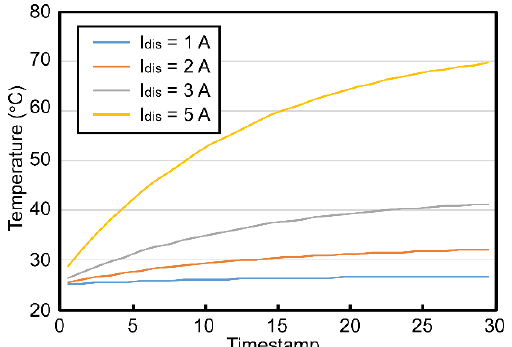
Figure 4. Battery temperature under varied discharge current, using the 18650 lithium-ion battery model described in Table 1.